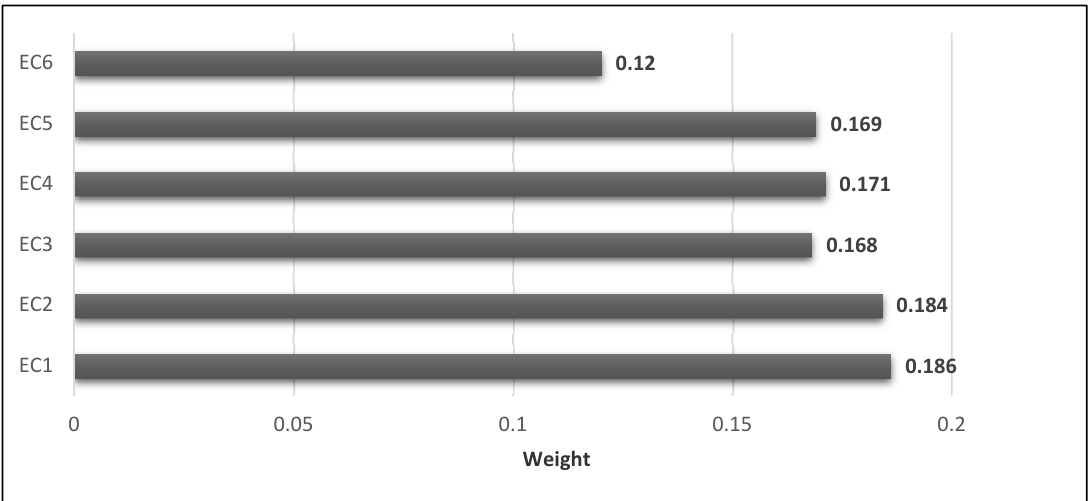
12 of 24 Table 6. Ranking of the green innovation criteria. Code